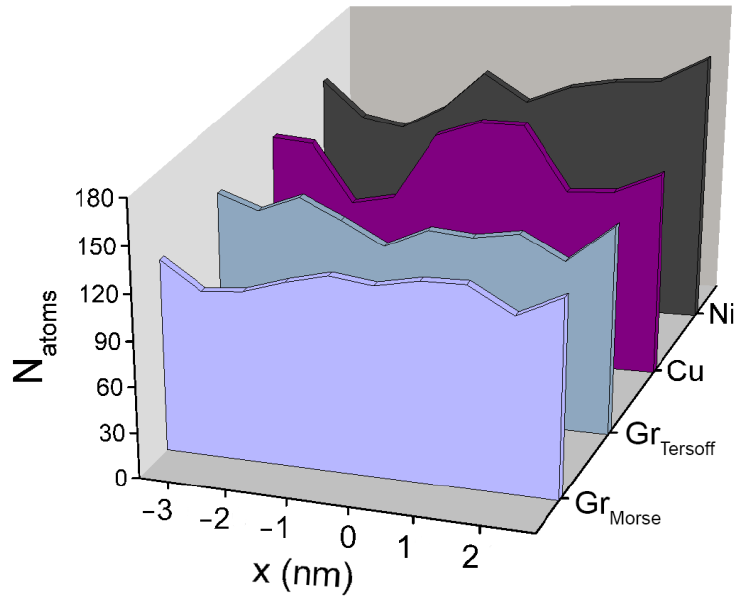
Figure 7. Numerical distribution density of SiC film atoms along the 0x direction for different types of substrates and interactions.